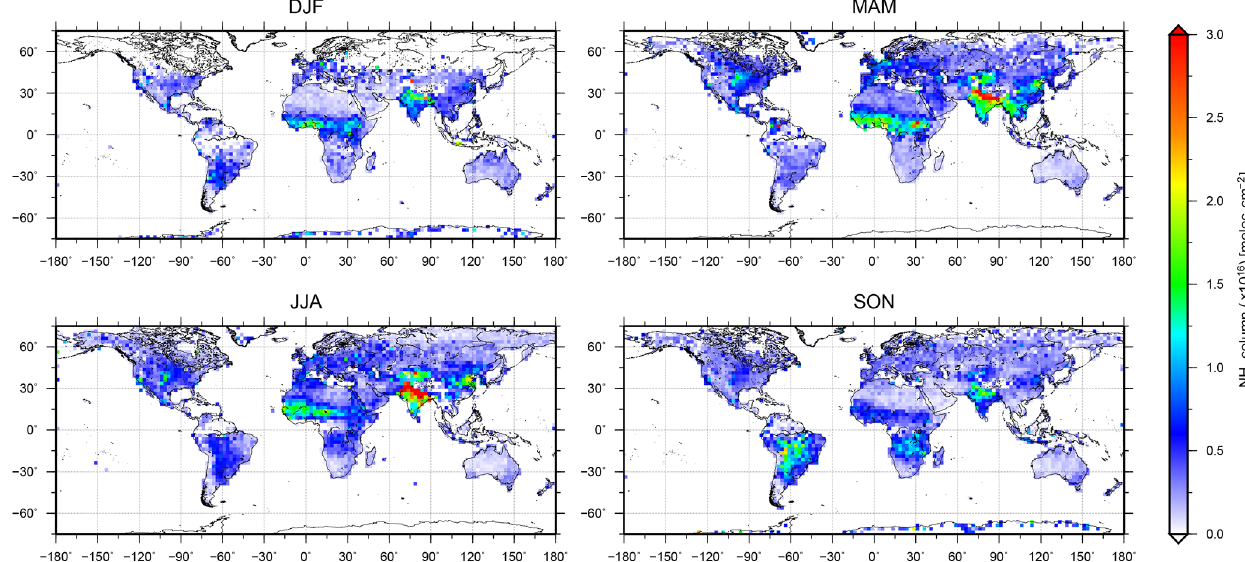
Figure 3. Horizontal distributions of ammonia column amounts for each season: December through February (DJF); March through May (MAM); June through August (JJA); and September through November (SON); as retrieved from GOSAT over 2 . 5 ◦ × 2 . 5 ◦ grids averaged from April 2009 to May 2014.